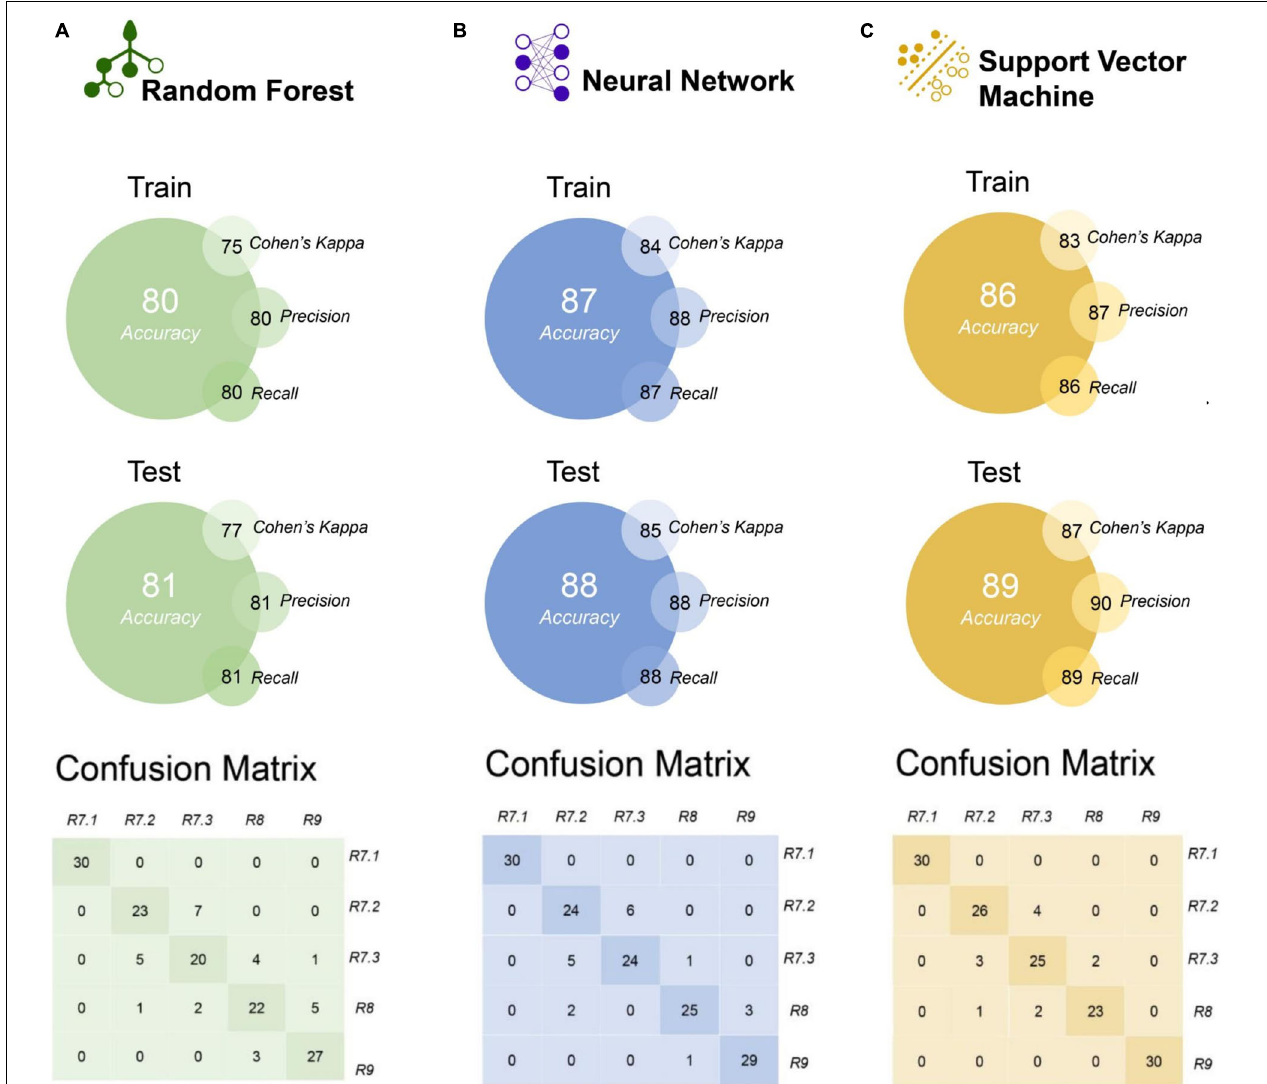
FIGURE 7 | Comparison of the random forest (RF), neural network (NN), and support vector machine (SVM) algorithms discriminating soybean seed maturation stages using autofluorescence-spectral data, and performance of the models based on accuracy, kappa, precision and recall (presented in percentage). The models were created using autofluorescence-spectral data extracted from seeds in the R7.1, R7.2, R7.3, R8, and R9 stages ( n = 500